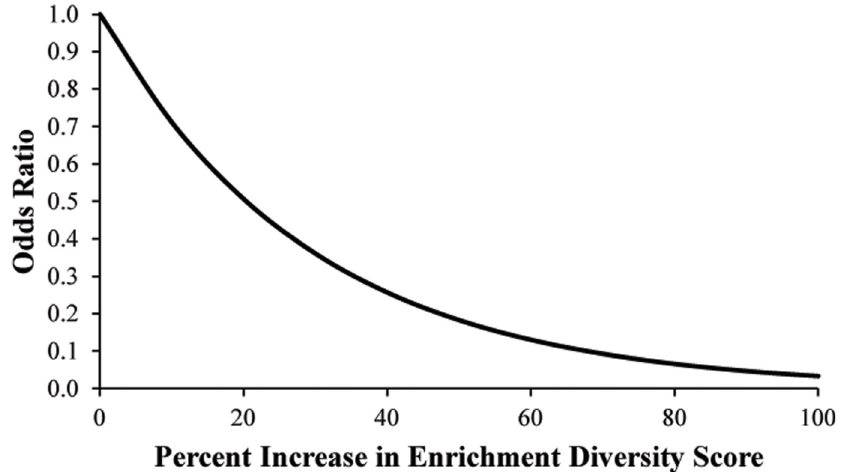
Fig 3. Odds of acyclicity decreases as Enrichment Diversity score increases. Grey line represents 15-year-old elephant; black line represents a 30-year-old elephant. See Greco et al. [47] for Enrichment Diversity Score definition and